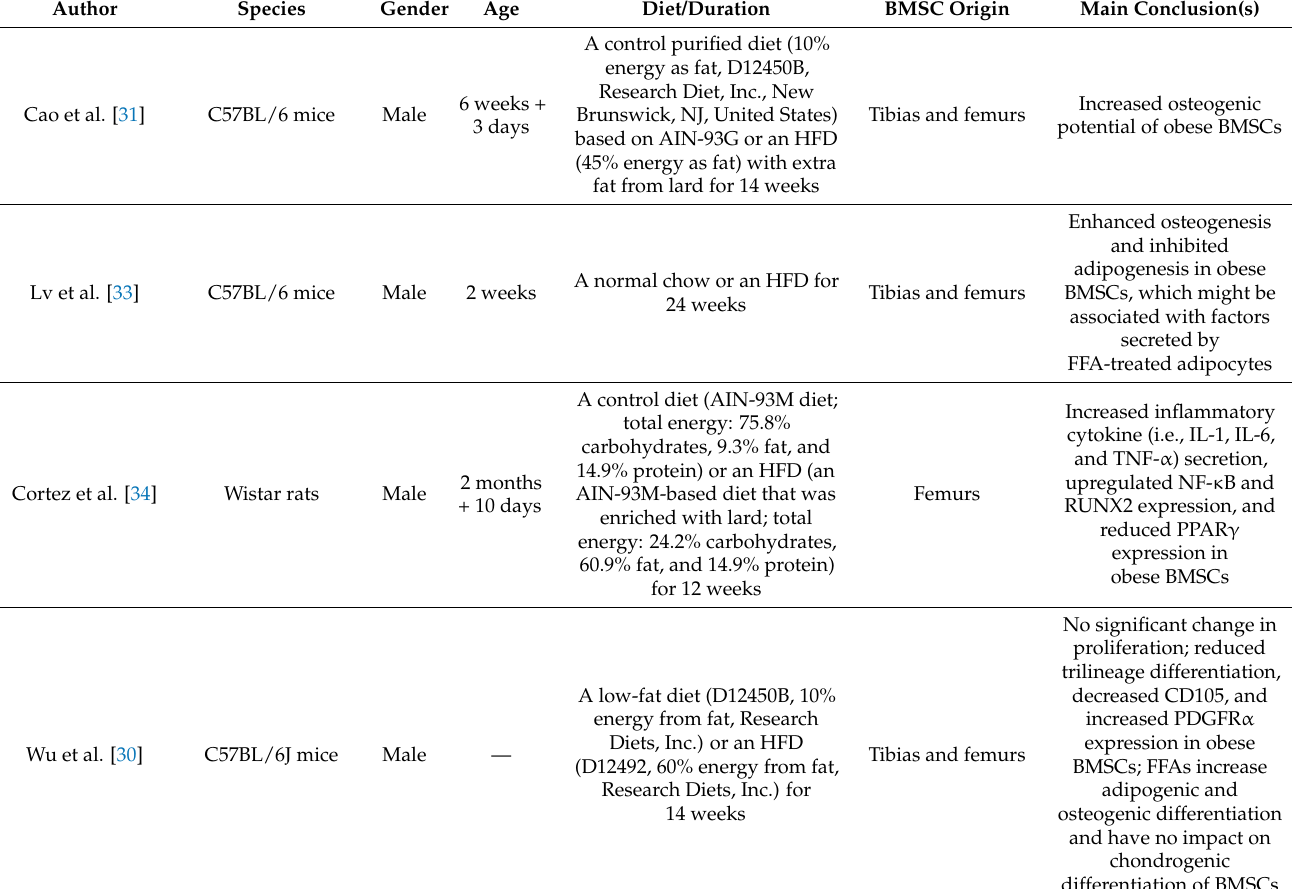
Table 1. Animal studies included in the